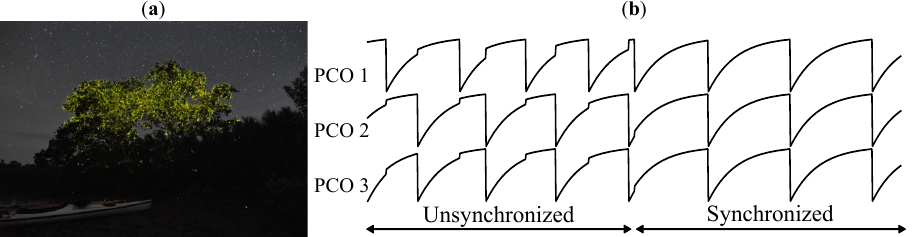
Figure 2. ( a ) A still shot that shows how fireflies can synchronously flash. ( b ) PCO synchronization demonstration. Diagram shows how three PCOs with random initial phase eventually